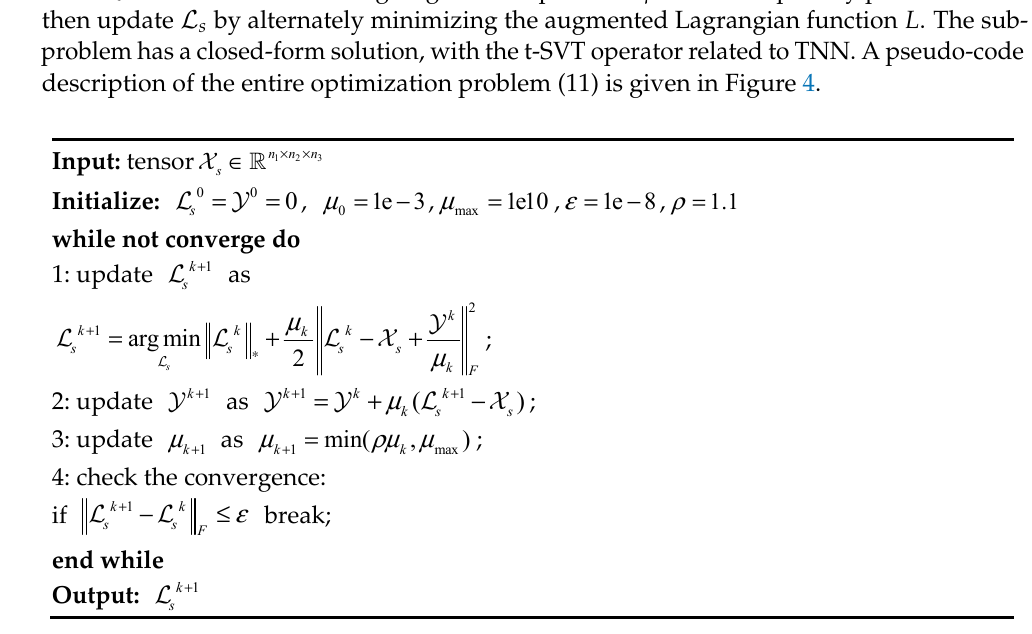
Figure 4. Our algorithm SLRTC.